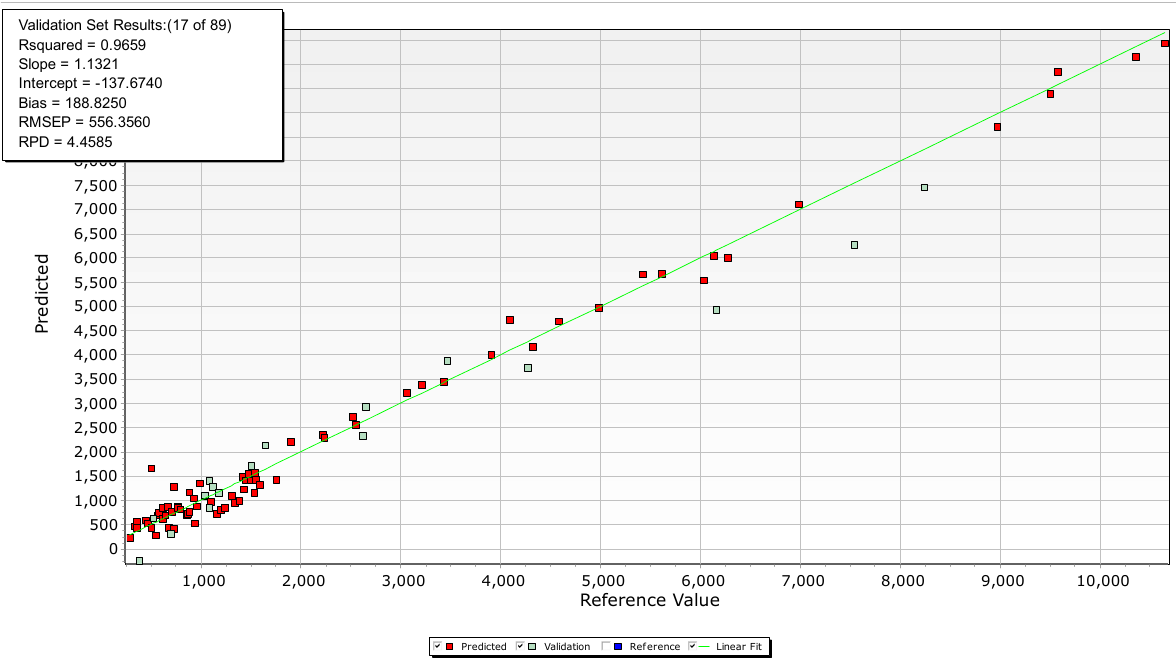
Figure 10. PLSR plot of predicted values and reference values of antimony concentration in copper concentrates. The plot contains both training and validation data of the model.